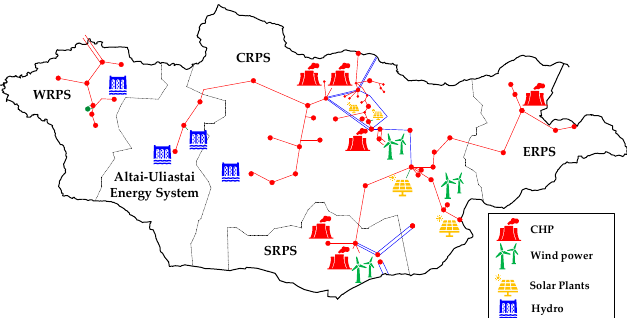
Figure 1. Representation of the Mongolia power system (MPS) indicating the main generation and transmission infrastructure.